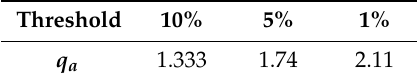
Table 5. Calculated q a